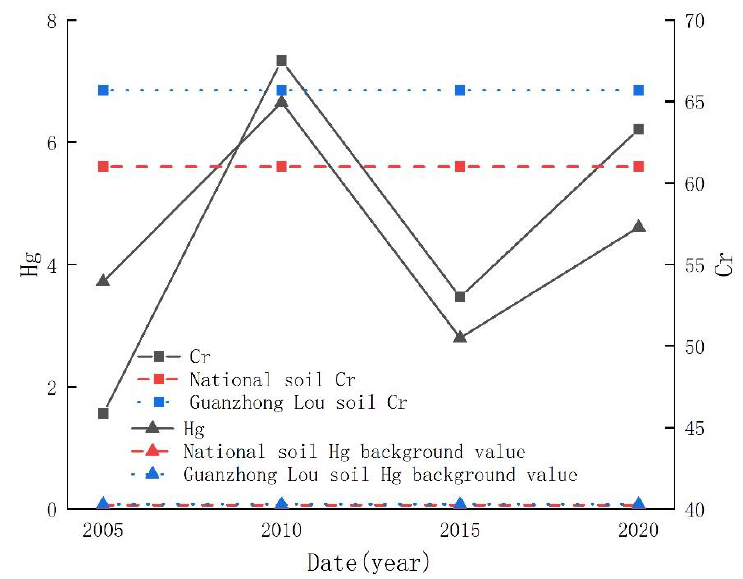
Figure 4. Comparison of average contents of Hg and Cr in soil in different years.